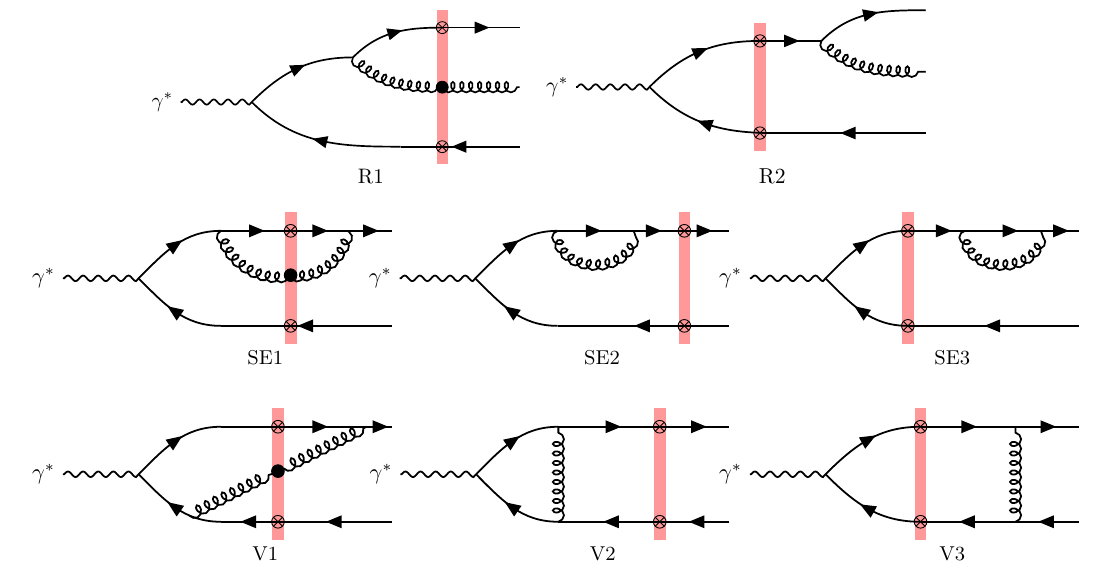
Figure 4 . Feynman diagrams that appear in the production of dijets at NLO. Top: real gluon emission diagrams. Middle: self energy diagrams. Bottom: vertex correction diagrams. As in the LO case, the crossed dot denotes the effective quark CGC vertex. The bullet (full circle) denotes the effective CGC gluon vertex, which for dijet production only appears at NLO. Diagrams obtained from q ↔ ¯ q interchange are not